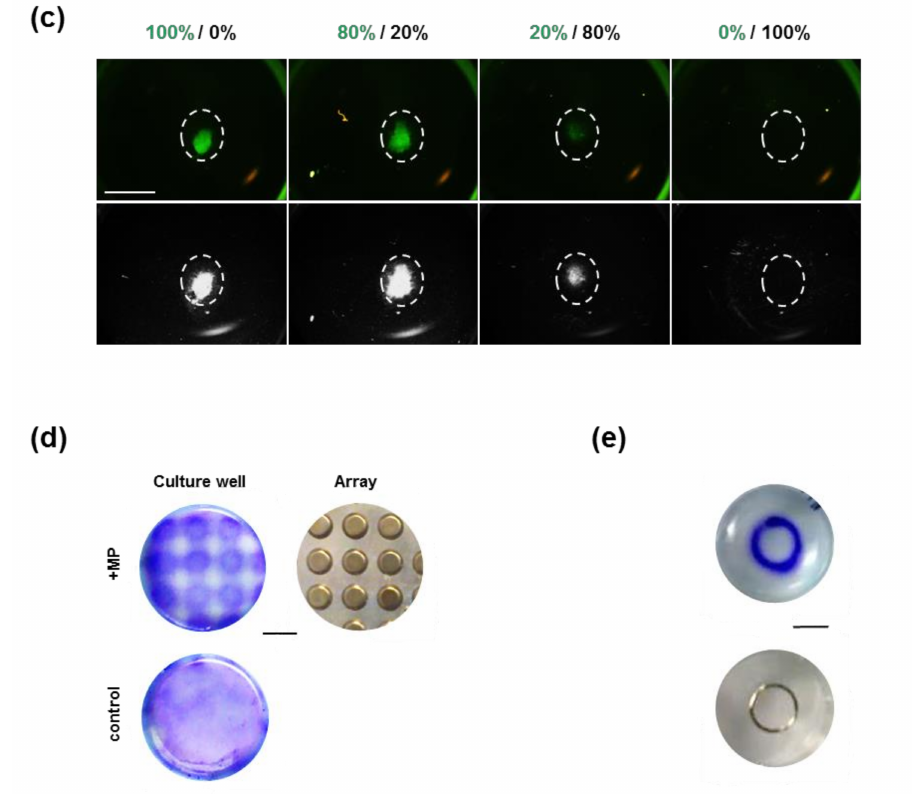
Figure 1. In vitro patterning of MSC seeding using MPs. ( a ) Fluorescence imaging of phalloidin-stained MSCs (green) showing internalised MPs (red) with dapi nuclear counterstain (blue). Bar = 50 µ m. ( b ) Toluidine blue staining 24 h after MP-labelled or unlabelled MSCs were seeded in static (top panel) or dynamic (bottom panel) conditions in the presence or absence of a magnet located under the culture well (white dashed circle). Bar = 10 mm. ( c ) Fluorescence imaging of the adherent population resulting from the incubation of MP-loaded GFP-positive (green) and unloaded GFP-negative MSCs mixed at di ff erent ratios (indicated as respective percentages), in the presence of a magnet placed under the plate (white dashed circle) for 48 h. Top panel: fluorescence channel, bottom panel: visible channel. Bar = 5 mm ( d ) Toluidine blue staining (left panel) 24 h after wells placed on a magnet array (right) were seeded with MP-labelled ( + MP) or unlabelled (control) MSCs. Bar = 9 mm. ( e ) Patterned cell distribution (top left) observed 48 h after seeding MP-labelled MSCs in a well placed on a metallic ring (top right) in contact with a magnet, resulting in matching cell seeding as seen after toluidine blue staining (blue). Bar = 10 mm. See image analysis in Figure